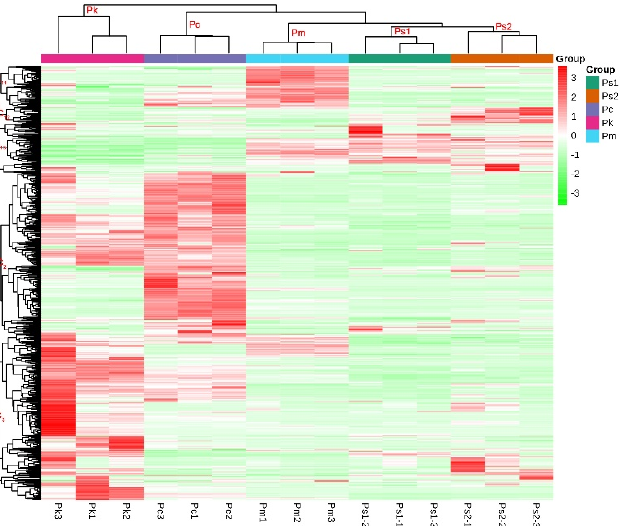
Figure 3. Cluster heatmap of the seed samples and metabolite classification. The cluster lines on the left represent the metabolite clusters. The cluster lines at the top represent sample clusters. Red and green indicate high and low metabolite contents, respectively.